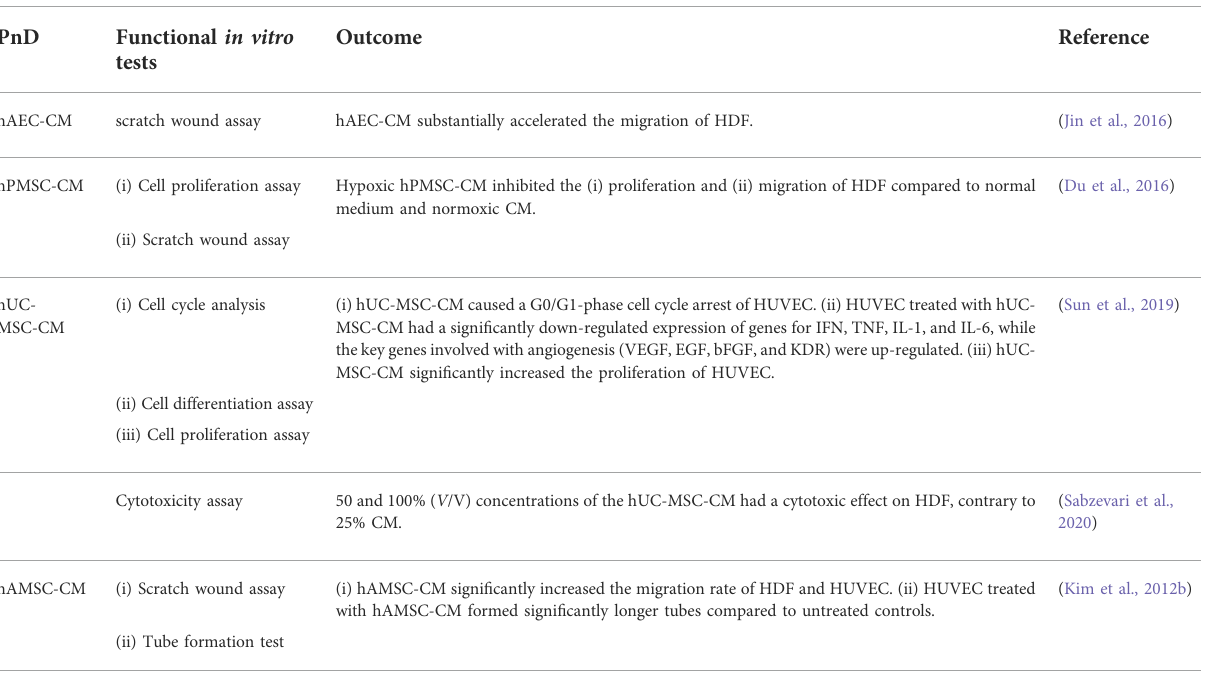
Perinatal cell-conditioned medium (CM) compared to / or combined with perinatal